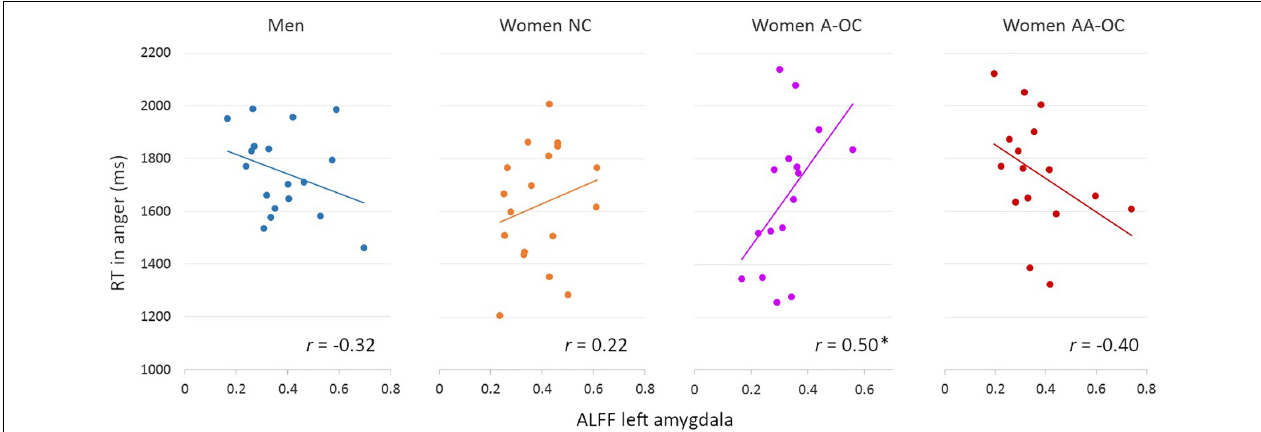
FIGURE 2 | Relationship between the amplitude of low-frequency fluctuations (ALFF) in the left amygdala and reaction time (RT) for angry faces by group. ALFF and RT were found to be moderately positively correlated for women on A-OC. * p < 0.05.